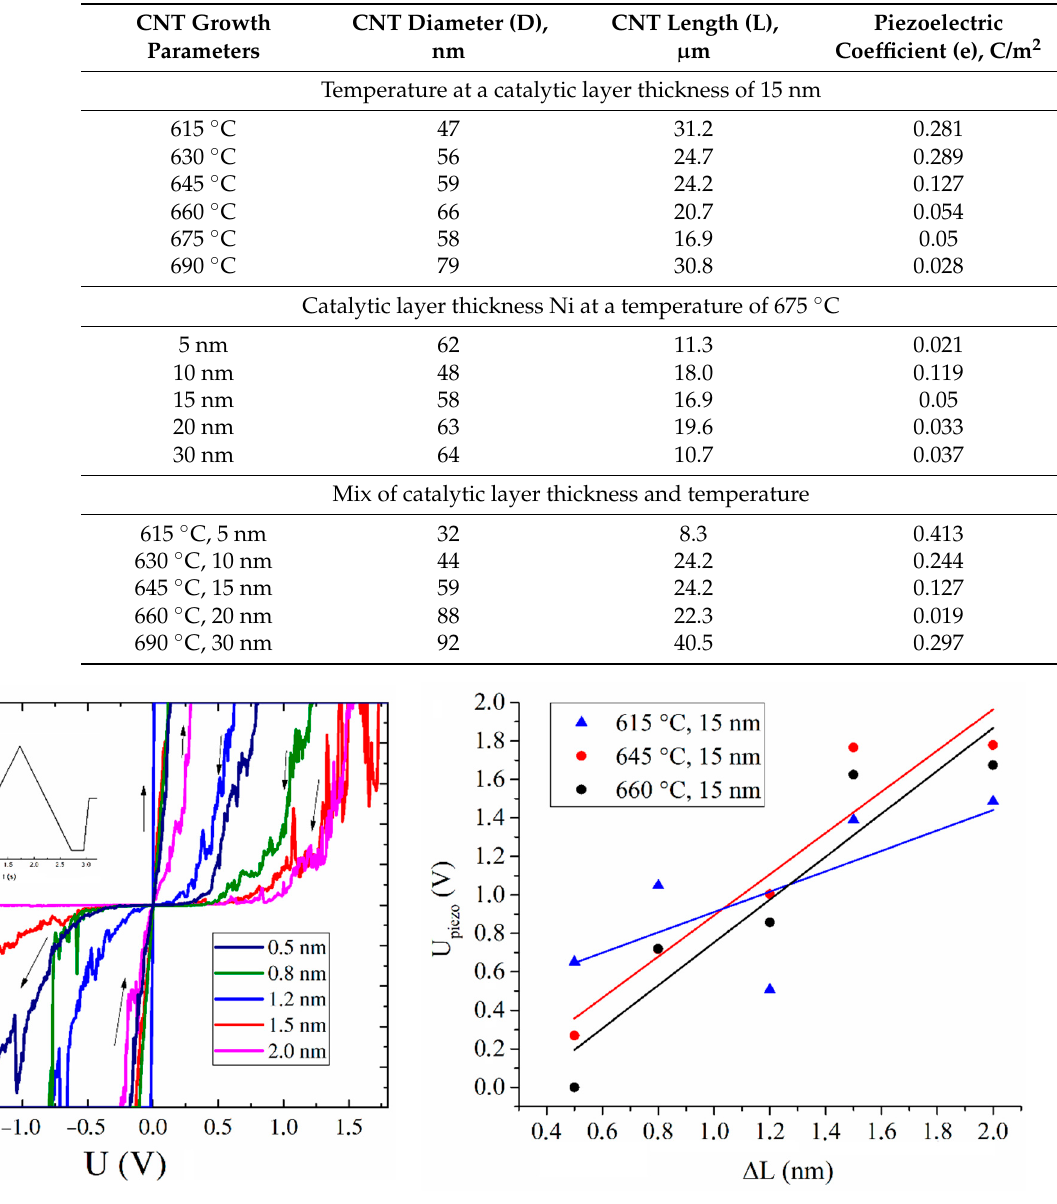
Table 1. Calculated values of the effective piezoelectric coefficients of CNTs.